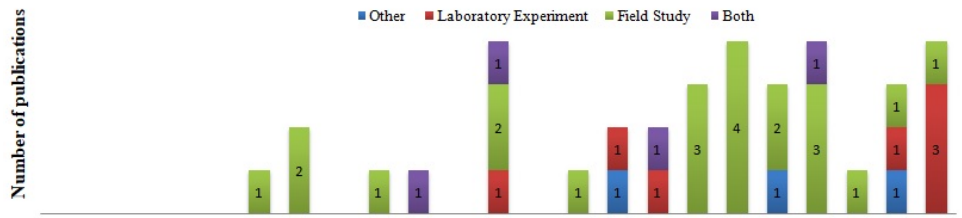
Figure 2. Temporal distribution of studies that related exotic plants with processes that threaten human and/or animal health and proportion of research types. human and/or animal health and proportion of research